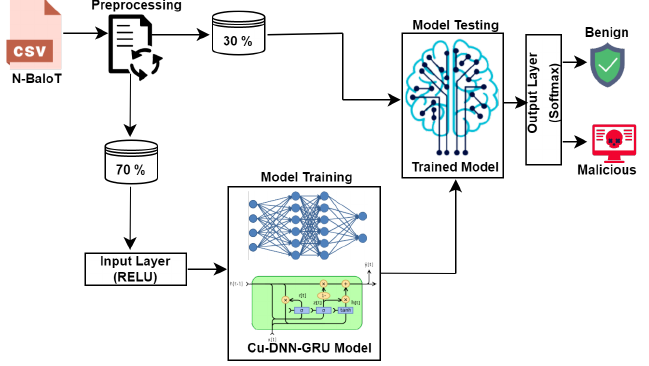
Figure 1. Work flow of proposed detection scheme. Table 2. Proposed hybrid model